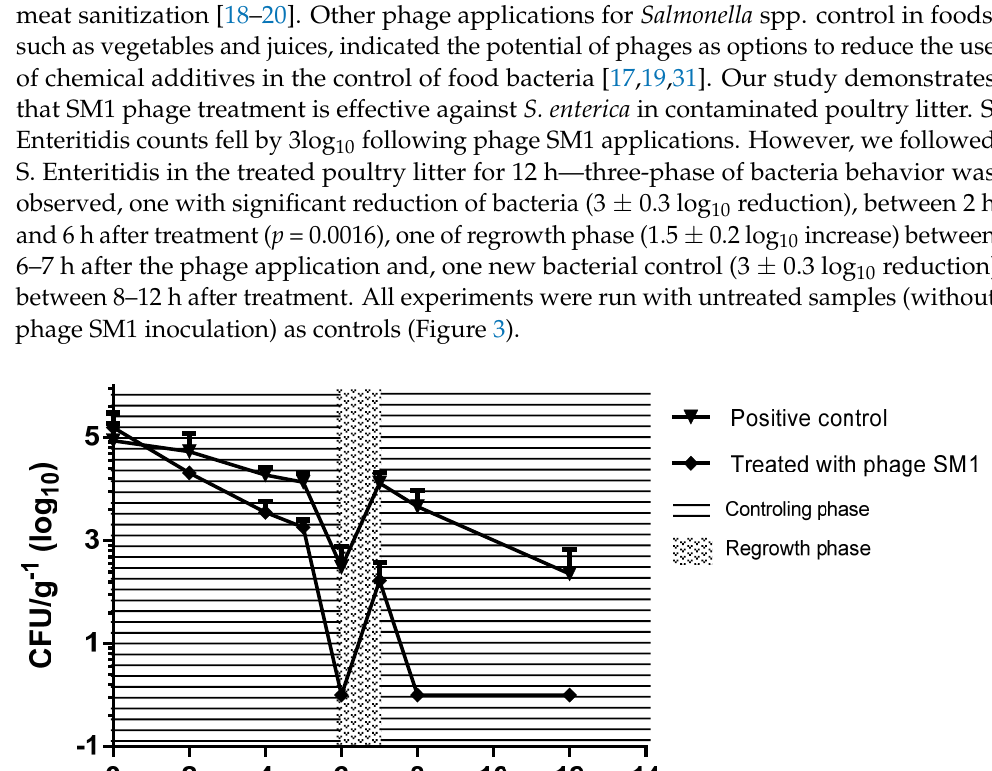
Figure 4. Efficacy of two sequent applications of phage SM1 for S. e . Enteritidis reduction on poultry litter. The positive S. e . Enteritidis control is presented by triangles, indicating the S. e . Enteritidis colonies enumeration on poultry litter without phage SM1 addition. The Salmonella population dynamics described above show the importance of high bacteriophage titers for effectiveness. The multiplicity of infection used in this study was 10 phage particles for each bacterial cell (MOI 10:1). A single phage application did not